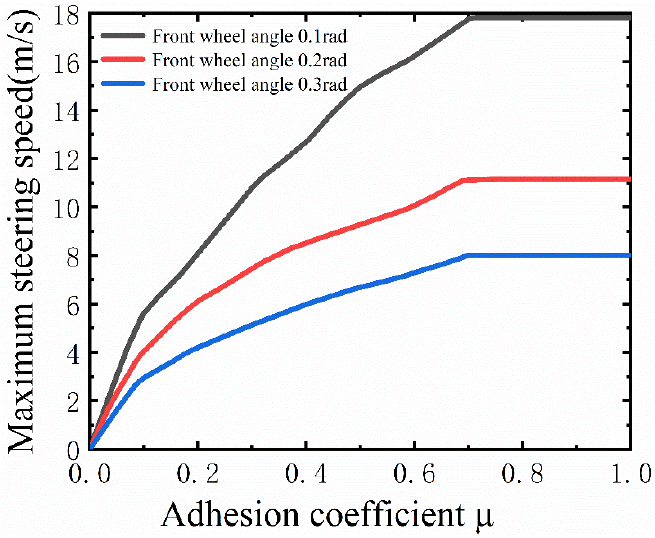
Figure 3. Maximum steering speed for different front wheel angles. Table 1. Angular threshold for lane change at different speeds of the car.